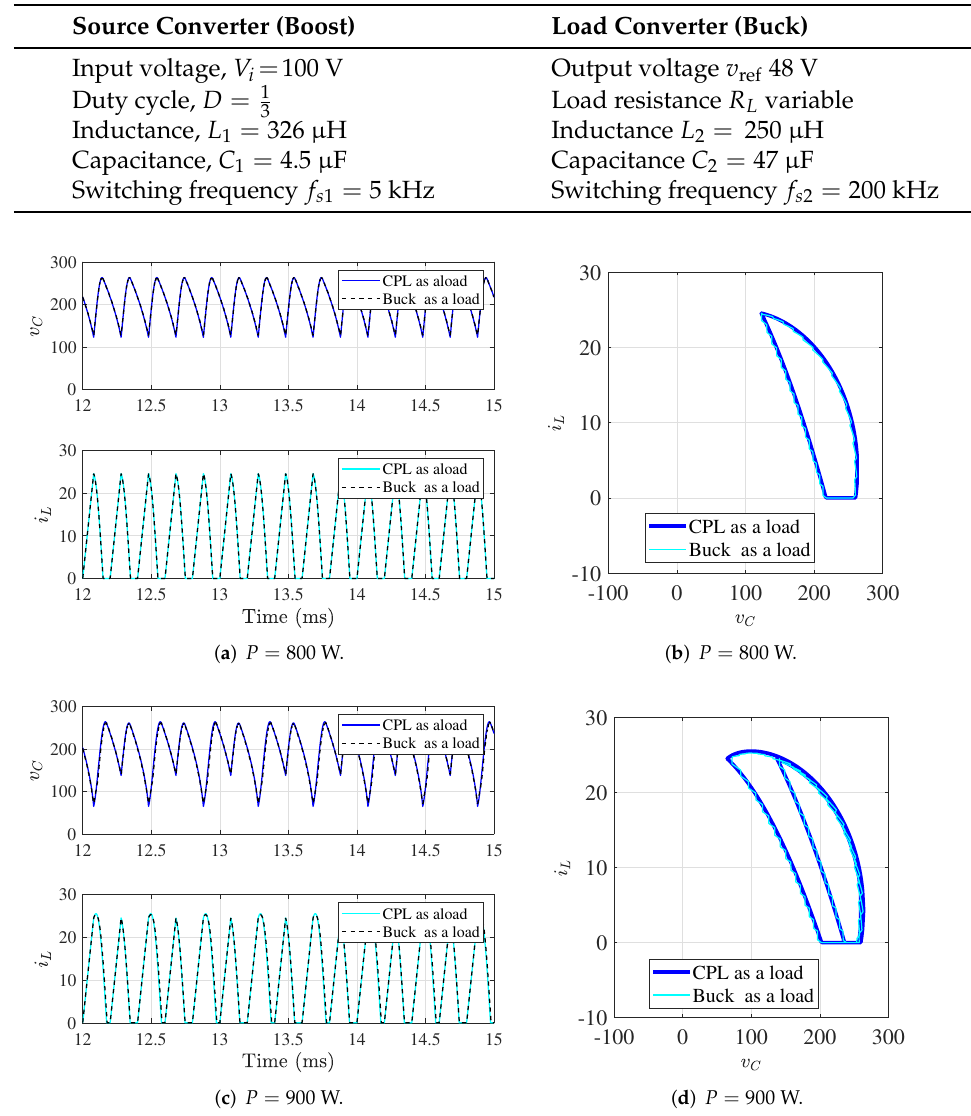
Table 1. Parameters used in the numerical simulations of the cascaded boost and buck converters.